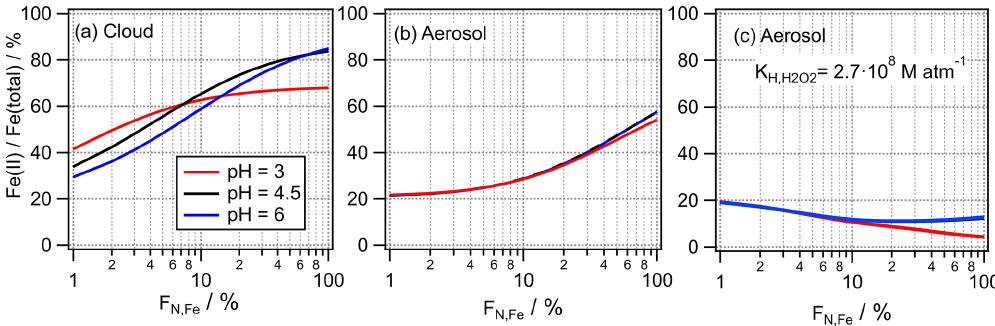
Figure 7. Predicted Fe(II) / Fe(total) ratios at pH = 3 , 4.5 and 6 and the conditions as given in Table 1. (a) Cloud, (b) aerosol and (c) aerosol